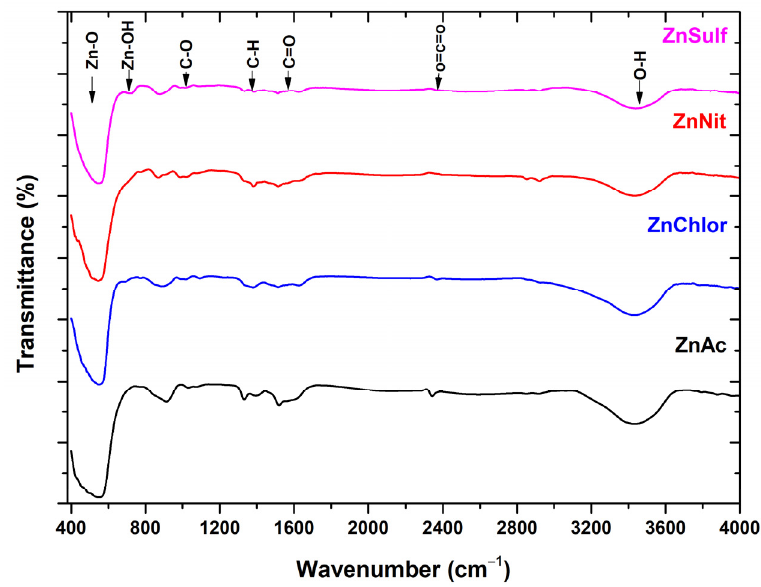
Figure 4. FT-IR spectra of ZnO nanoparticles, synthesized using as precursor zinc acetate dehydrate (ZnAc) (in black), zinc nitrate hexahydrate (ZnNit) (in red), zinc chloride (ZnChlor) (in blue), zinc sulphate heptahydrate (ZnSulf) (in purple).